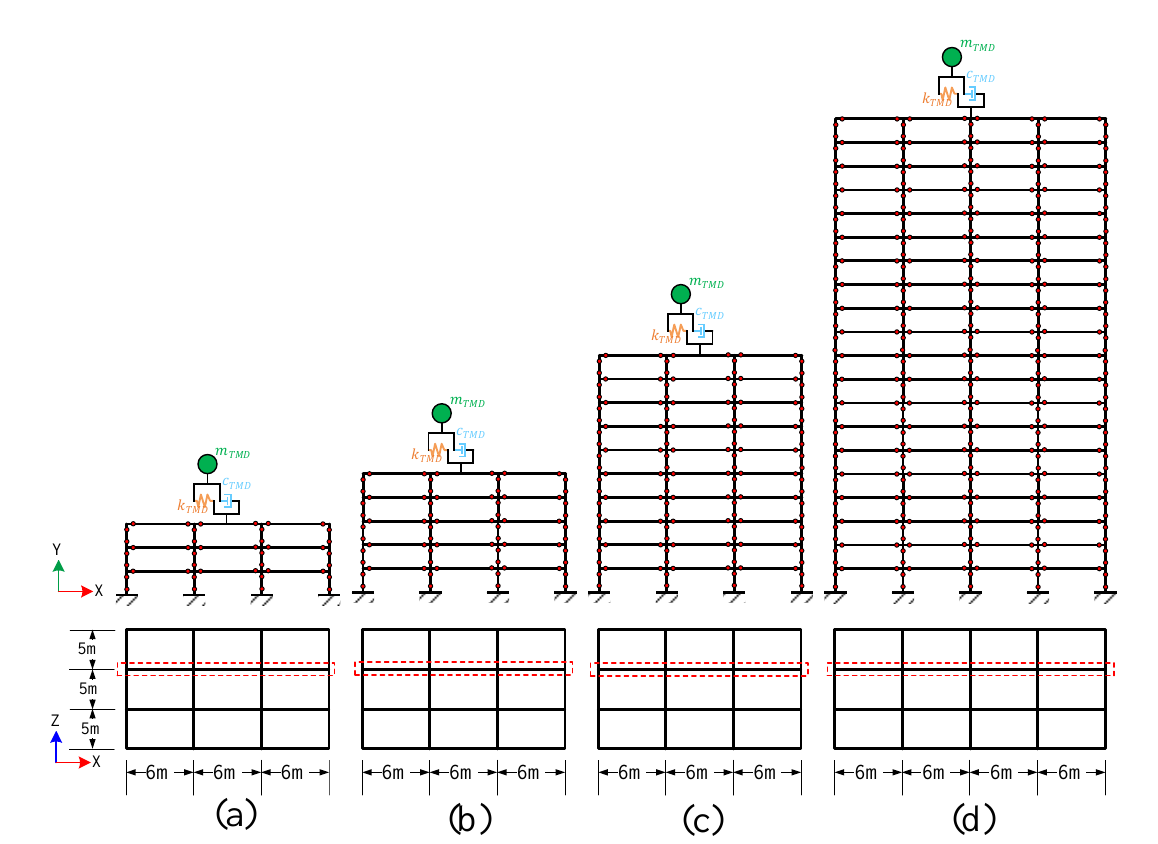
Figure 1. Structural layout of the building frame (for all frames: bay width = 6 m and story height = 3 m): ( a ) 3 story; ( b ) 5 story; ( c ) 10 story; ( d ) 20 story.